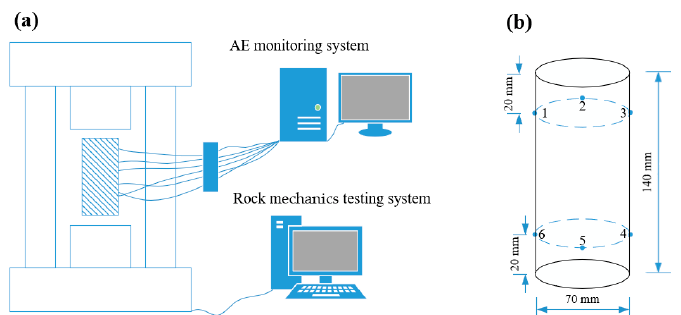
Figure 2. A schematic diagram of the uniaxial loading and AE monitoring system. ( a ) The schematic diagram of the uniaxial loading; ( b ) the schematic diagram of an AE sensor’s layout.